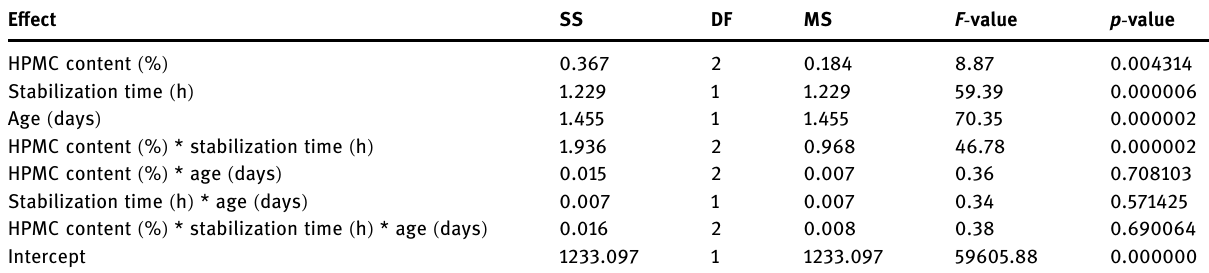
Table 13: Analysis of variance ( ANOVA ) for elasticity module results of mortars with 48 and 72 h of stabilization at 28 and 42 days E ff ect SS DF